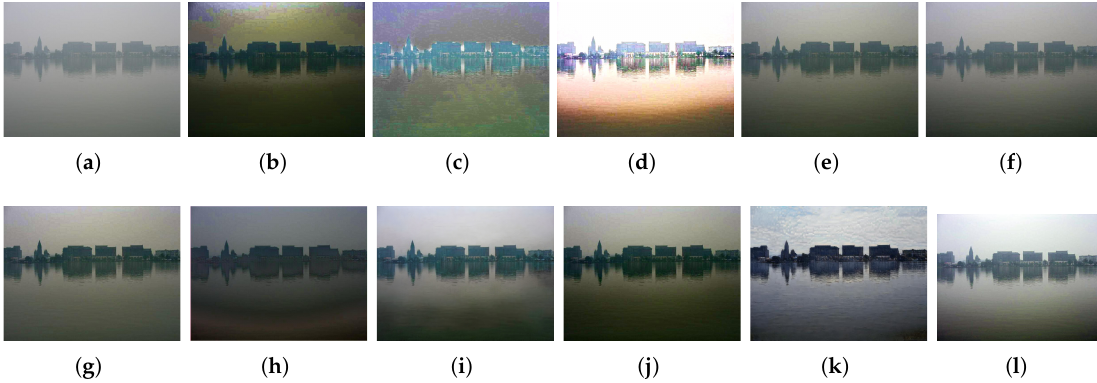
Figure 7. Real light hazy images and corresponding dehazing results from several state-of-the-art methods (best viewed in color). ( a ) Hazy Image. ( b ) DCP. ( c ) FVR. ( d ) BCCR. ( e ) CAP. ( f ) DehazeNet.